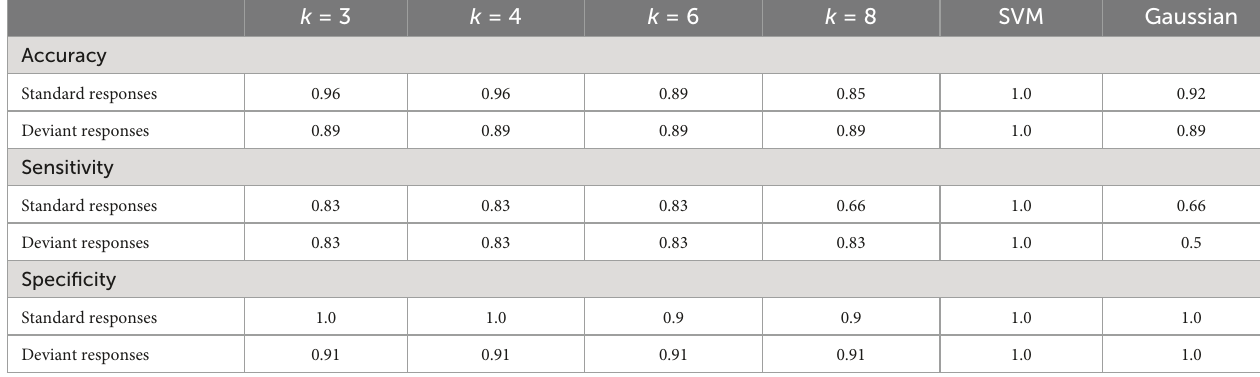
TABLE 2 Accuracy, sensitivity, and specificity obtained by cross-validation for responses to standard, deviant stimuli; k is the number of neighbors used in the classification algorithm. k = 3 k = 4 k = 6 k = 8 SVM